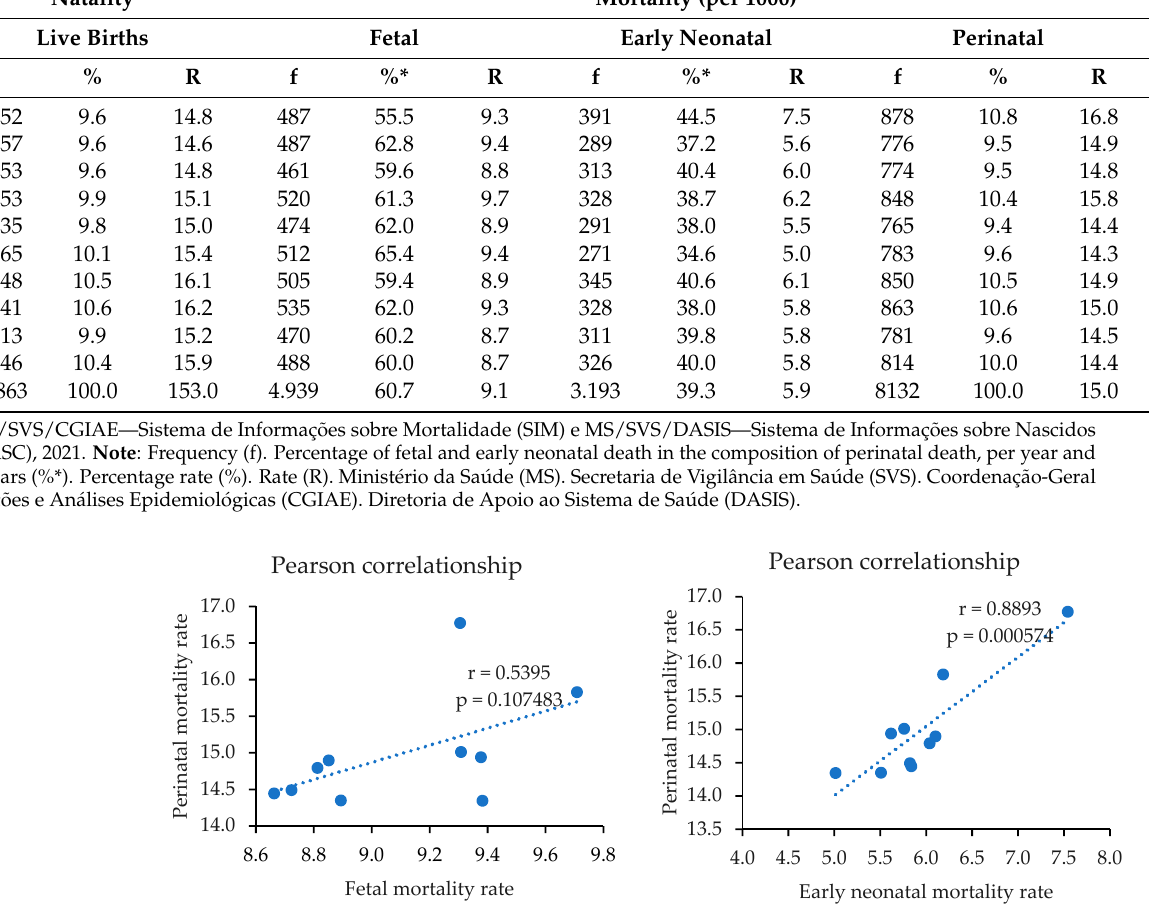
Figure 1. Effect of variations in fetal and early neonatal mortality rates on perinatal mortality rates. Esp í rito Santo, Brazil, 2008–2017. Source: MS/SVS/CGIAE—Sistema de Informaç õ es sobre Mortalidade (SIM) e MS/SVS/DASIS—Sistema de Informaç õ es sobre Nascidos Vivos (SINASC), 2021. Figure 2 shows the results of the analyses performed on the behavior of the perinatal mortality rate by health region and in Esp í rito Santo between 2008 and 2017. The results show a decreasing trend in the PMR in Esp í rito Santo, from 16.8/1000 in 2008 to 14.4/1000 in 2017 (Table 1 and Figure 2), a reduction of around 14.3% in 10 years and 1.4% per year. From 2008 to 2017, the early neonatal component (zero to six full days of life) showed a reduction of 22.7%, and the fetal component showed a smaller decrease of 6.5%. In the analysis by health region, differences in results by region were observed. From 2008 to 2017, the South region had a PMR of about 17.1/1000 total births, while the Central North and Metropolitan regions had the lowest average rates (15.6 and 14.2/1000 total births). The greatest reduction in the PMR was observed in the health region of the South, around 29.3%, followed by the Central North, 23.9%. Additionally, the smallest reduction was presented by the Metropolitan region, 1.1% (Figure 2). In 2017, the Central North region had the highest PMR, 14.9/1000 total